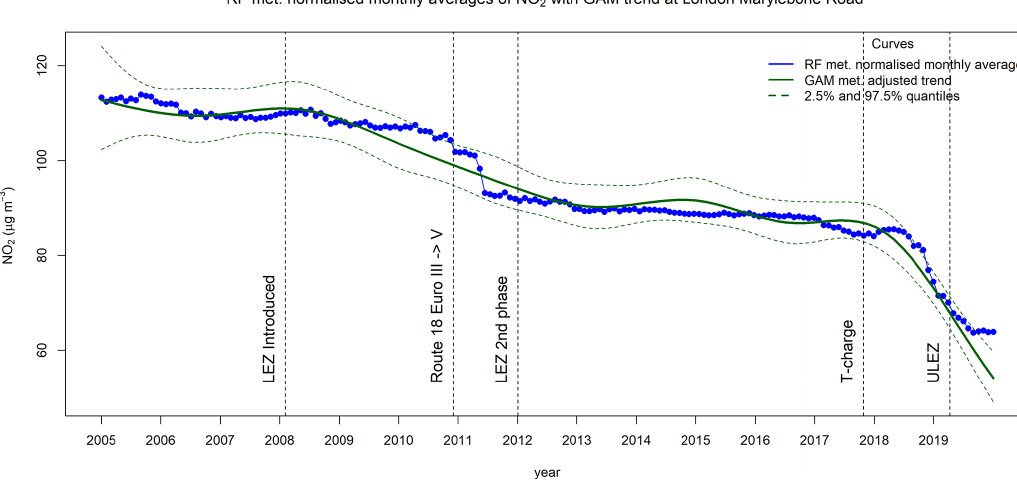
Figure 14. Meteorologically normalised trend (monthly averages) from the RF model (blue curve) together with a meteorology-adjusted smooth trend (dark green curve) from AirGAM with a 95% confidence region (dashed curves) for NO 2 at Marylebone Road, London, for 2005–2019 (units in % and µgm − 3